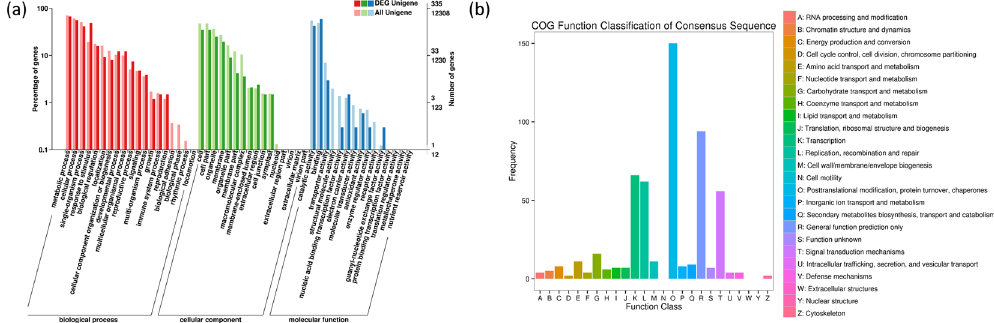
Figure 6. GO functional annotation and COG annotation of Zostera japonica DEGs. ( a ) GO annotation, where red represents biological process, green represents cellular component, and blue represents molecular function. The x-axis represents GO categories, the y-axis (left) represents the percentage of genes, and the y-axis (right) represents the number of genes. (b) COG annotation, where the x-axis represents COG categories and the y-axis represents the number of